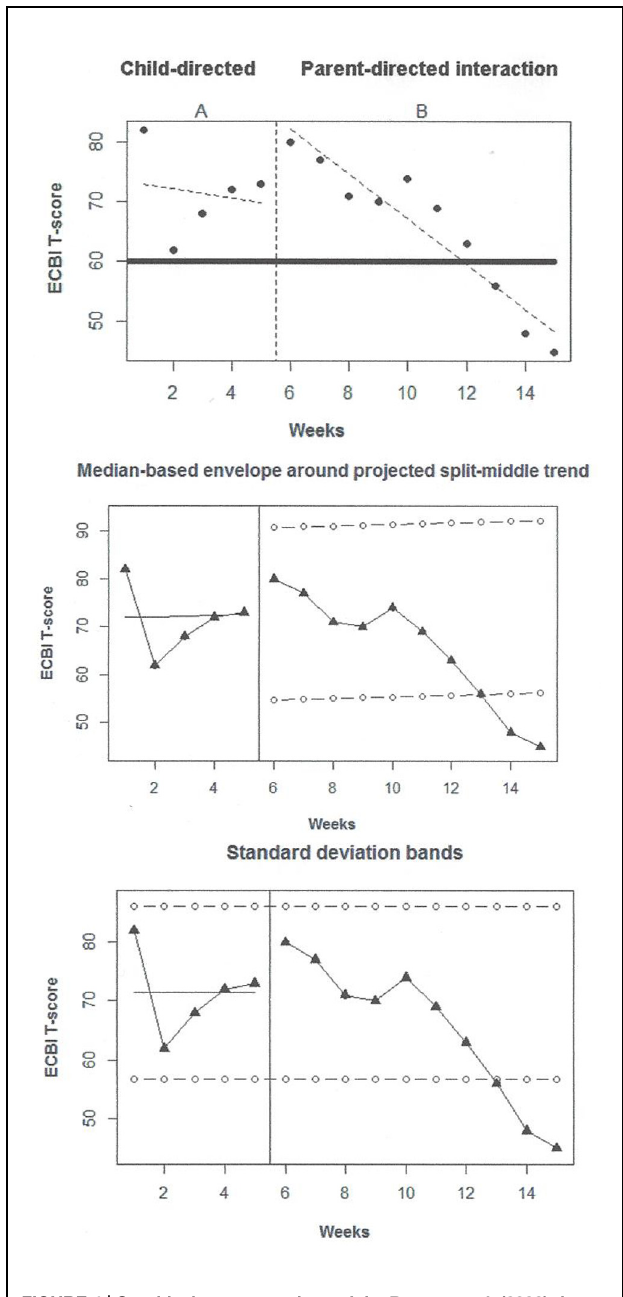
FIGURE 4 | Graphical representations of the Bagner et al. (2009) data gathered through observation in the family context: upper panel – trend lines; middle panel – split middle and trend envelope; lower panel – standard deviation